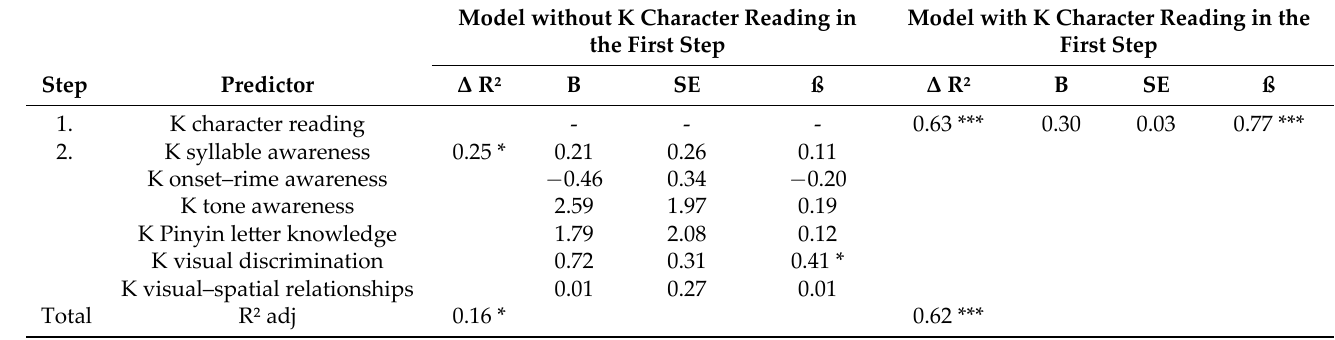
Table 3. Hierarchical regression explaining Grade 1 Chinese character reading from K phonological awareness, Pinyin letter knowledge, and visual perception